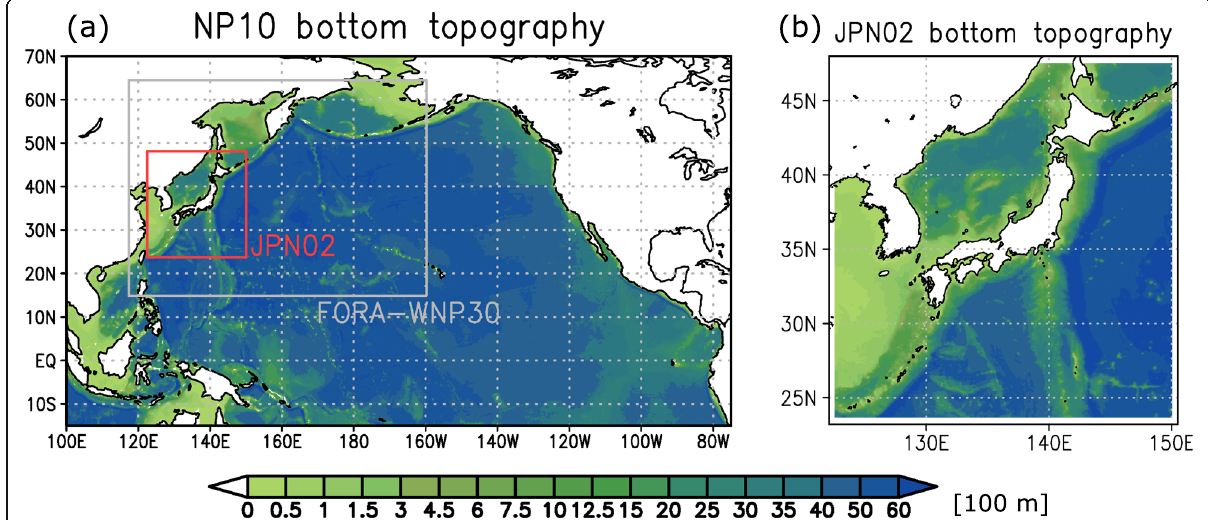
Fig. 1 Model domains of a NP10 and b JPN02. In ( a ), the gray box indicates the FORA-WNP30 domain, and the inner redbox indicates the JPN02